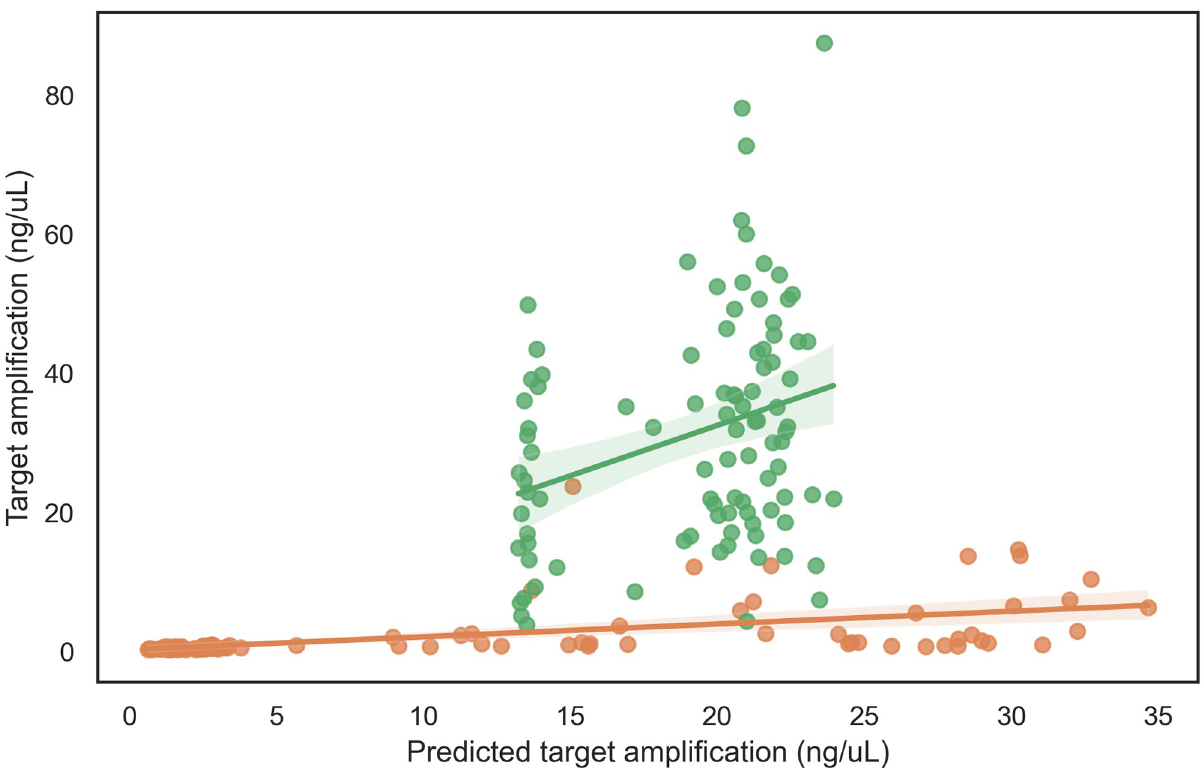
Fig 4. The final random forest regression model reliably predicts the amplification efficacy of individual primers. The amplification predicted for Round 2 amplification was accurate only for low-performing primers (orange). Updating the model with Round 2 amplification data resulted in a model that predicted highly effective primers (green). The amplification efficacy of the primers selected for Round 3 were highly variable despite similar predictions. Nevertheless, the final random forest regression model did not select any poor performing primers. The model was not used to predict the primers used in Round 1.